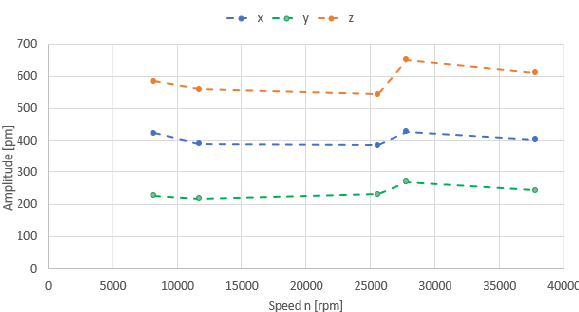
Fig. 6. Comparison of US frequency (25.4 kHz) at different rotation speeds of “Ultrasonic 20 linear”